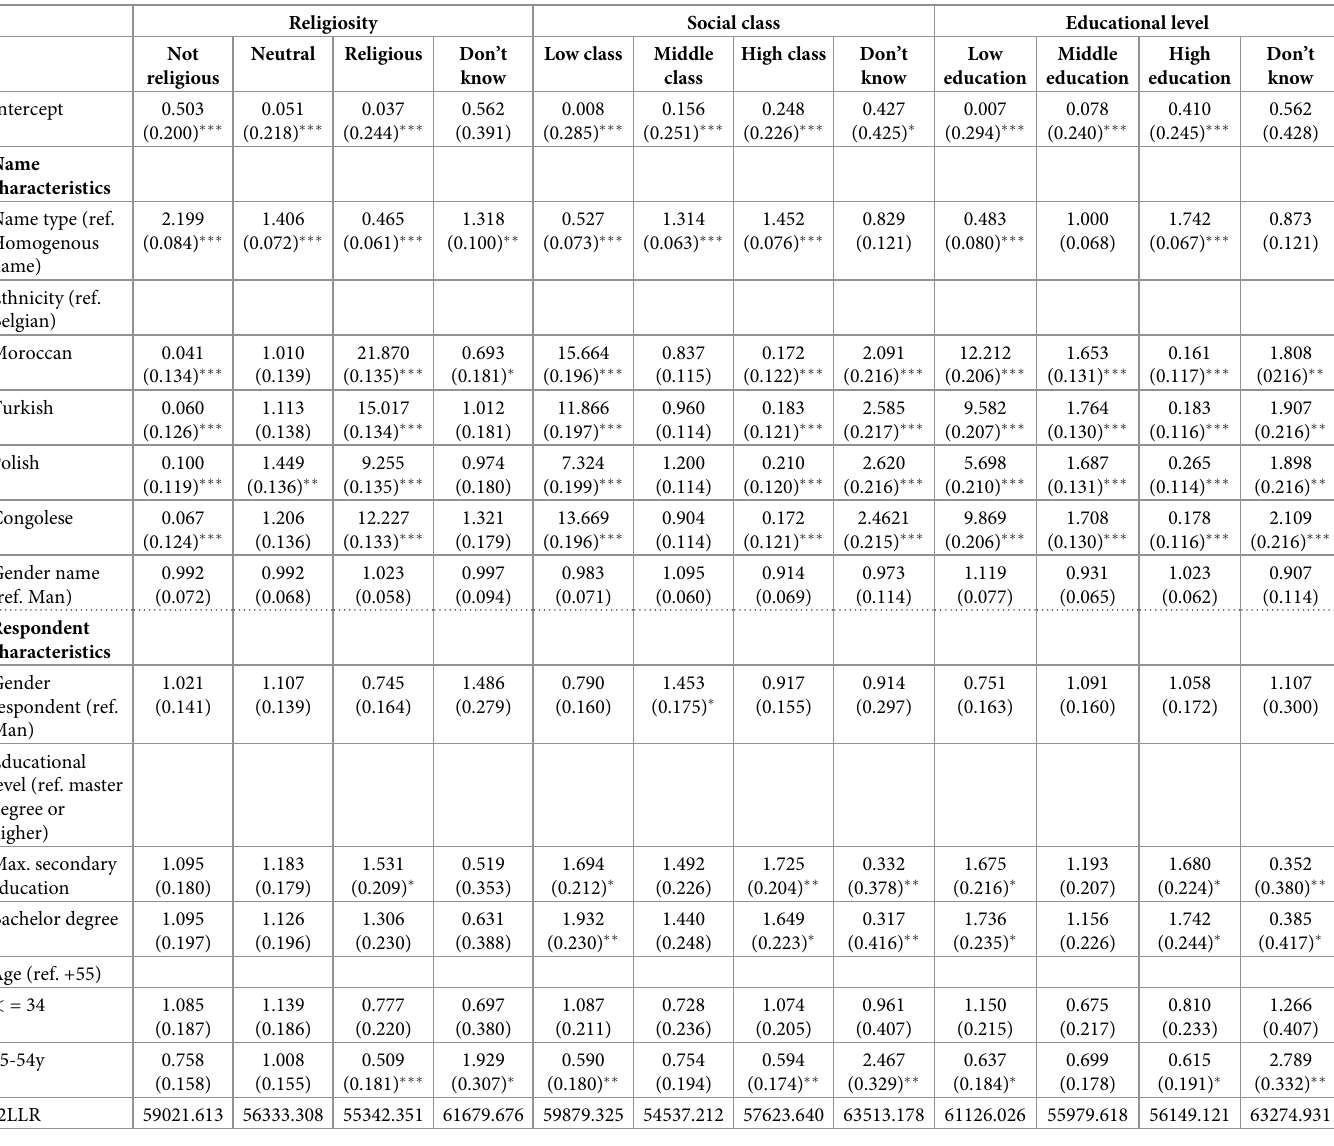
Table 4. Multilevel logistic regression analysis with individual level fixed effects on religiosity, social class and educational level [n =